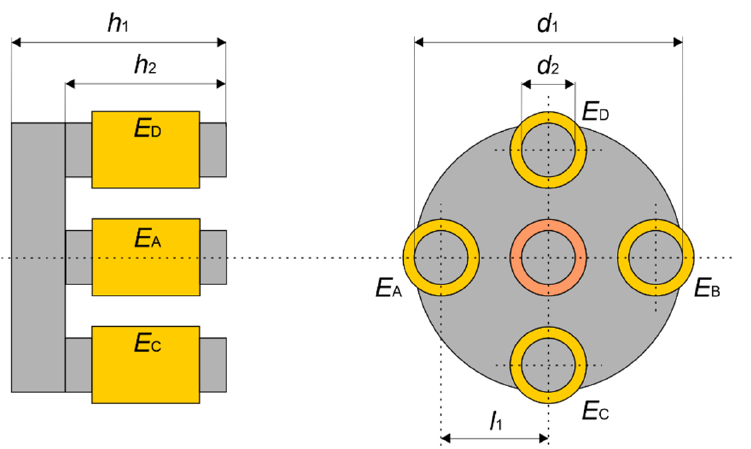
Figure 9. Dimensions of the eddy current transducer: d 1 = 12 mm, d 2 = 2 mm, l 1 = 5 mm, h 1 = 10 mm, and h 2 = 6 mm.